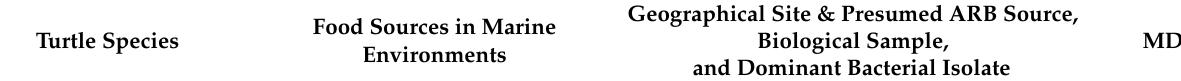
Juveniles: Shrimp,